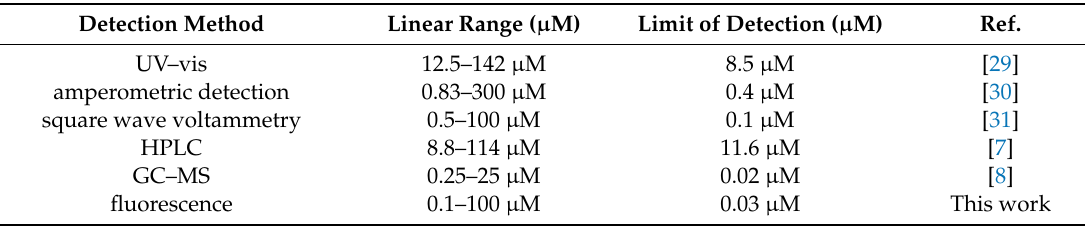
Figure 2. ( a ) Fluorescence changes in 3,5-diaminobenzoic acid with di ff erent concentrations of ca ff eine (0–1000 µ M), excitation at 280 nm. ( b ) Fluorescence intensity of 3,5-diaminobenzoic acid with addition of di ff erent concentrations of ca ff eine. The corresponding inset is the fluorescence intensity linear graph of 3,5-diaminobenzoic acid with di ff erent concentrations of ca ff eine (0.1 µ M–100 µ M). Table 1. Di ff erent methods for the determination of ca ff